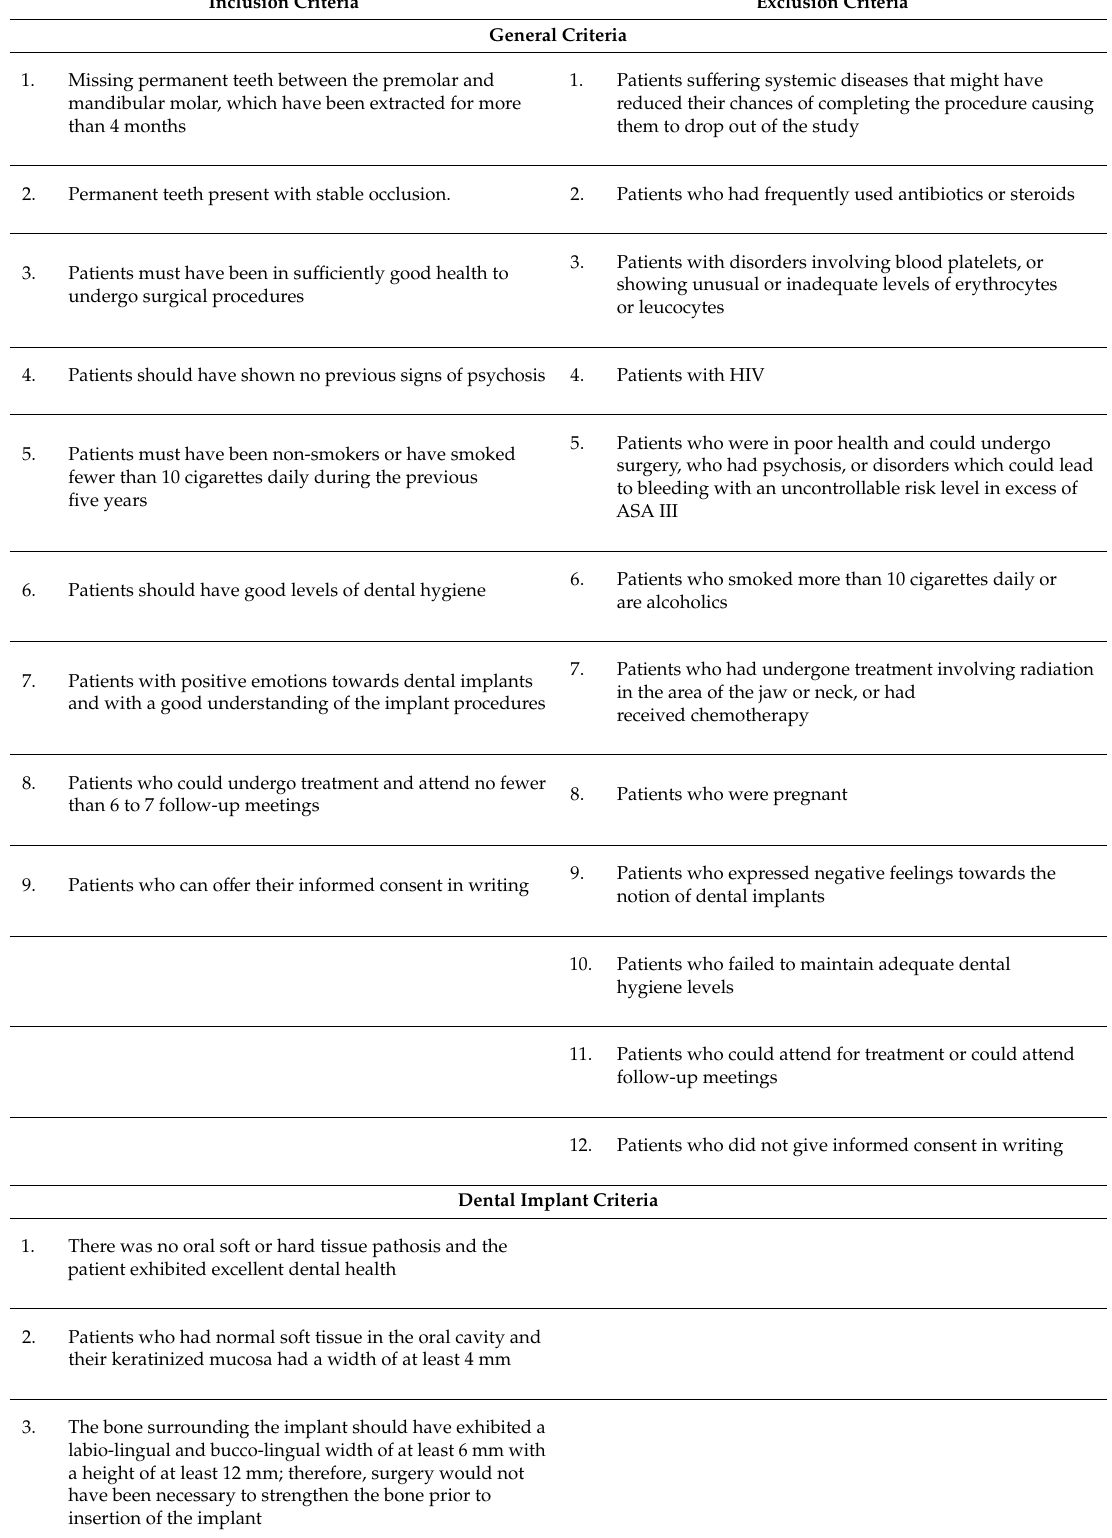
Table 1. Criteria used for inclusion or exclusion in the